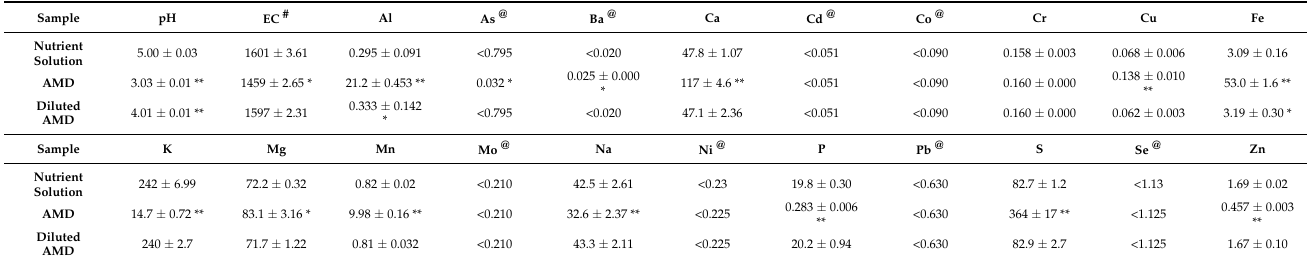
Table 1. The results of inductively coupled plasma - optical emission spectrometry (ICP-OES) analysis of acid mine drainage and nutrient